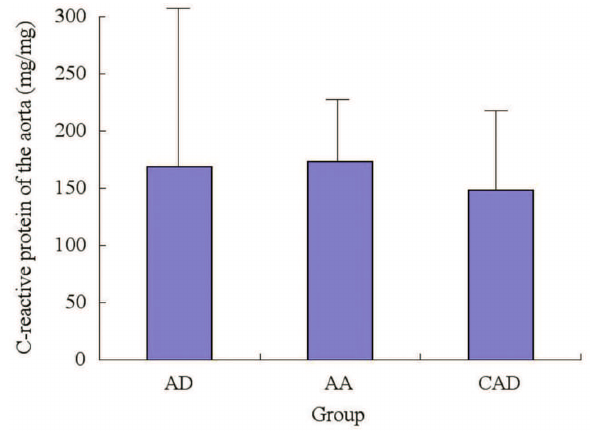
groupsFig. Fig. 5. Linear correlation between plasma D-dimer and plasma hypersensitive C-reactive protein levels of all four investigated